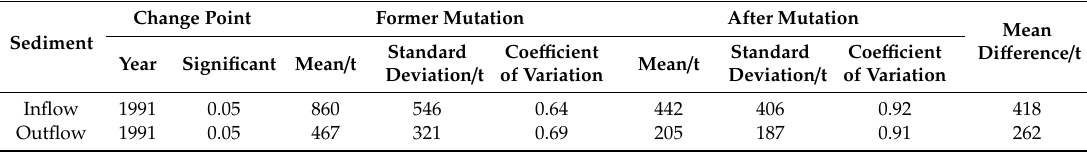
Figure 5. Outflow sediment time series combinatorial mutation test. ( a ) M–K test; ( b ) First order change point identification; ( c ) Second order change point identification (1975–1991); ( d ) Second order change point identification (1991–2015). Table 2. Mutation analysis of sediment time series of inflow and outflow.